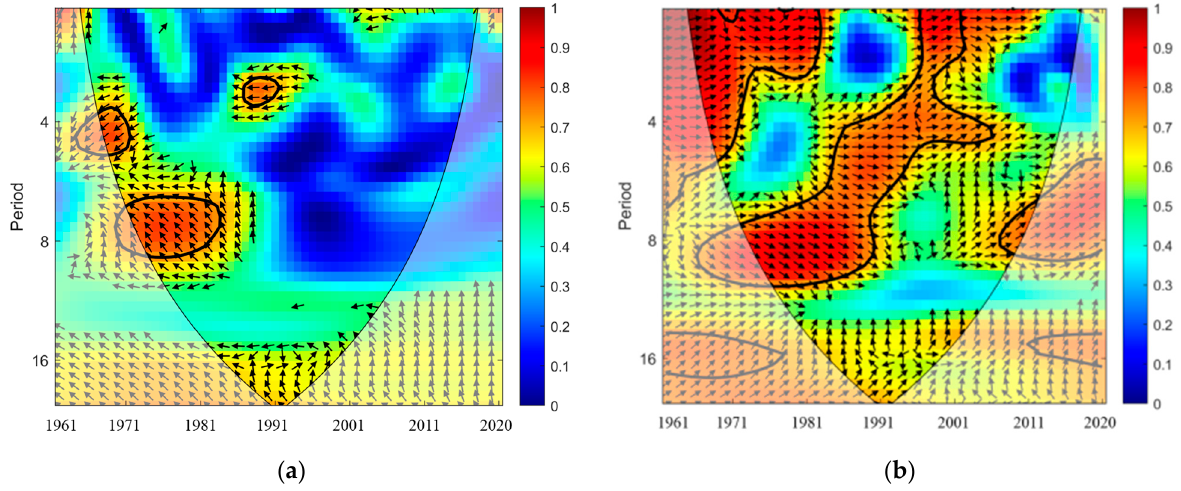
Figure 5. Bivariate Wavelet Coherency between Huayuankou natural runoff and annual mean temperature ( a ) and annual total precipitation ( b ). The horizontal axis is the time series from 1961–2020. Arrows show the phase angles of the wavelet spectra. Thin solid lines demarcate the cones of influence, and thick solid lines show the 95% confidence levels.